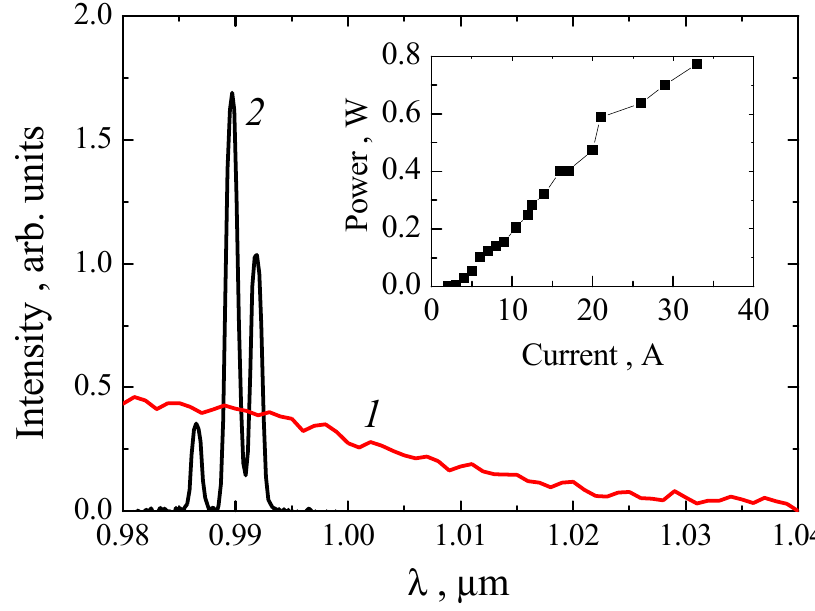
Figure 4. The emission spectrum at room temperature of a microstrip laser made from the structure C at a current of 2 A (current density of 3.7 kA/cm 2 ) (1) and a current of 14 A (current density of 26 kA/cm 2 ) (2). The inset shows the power-current characteristic of this microstrip laser.